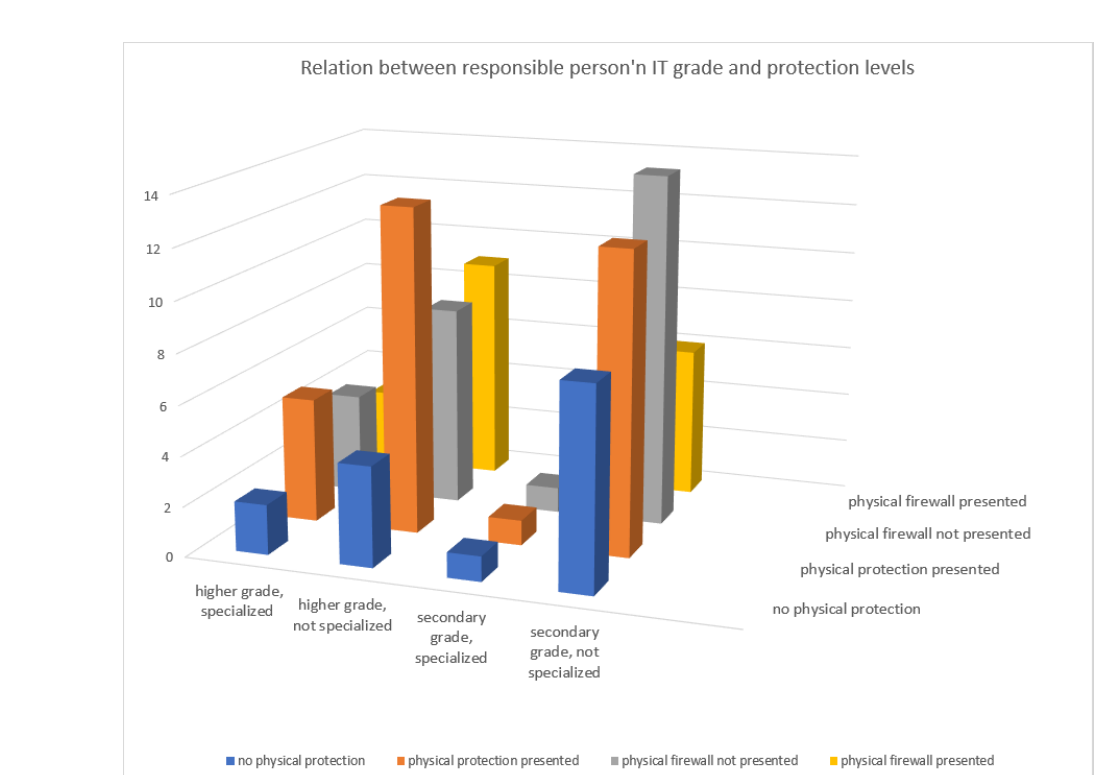
Figure 5. Correlation between the companies’ decision makers’ IT skills and the presented security